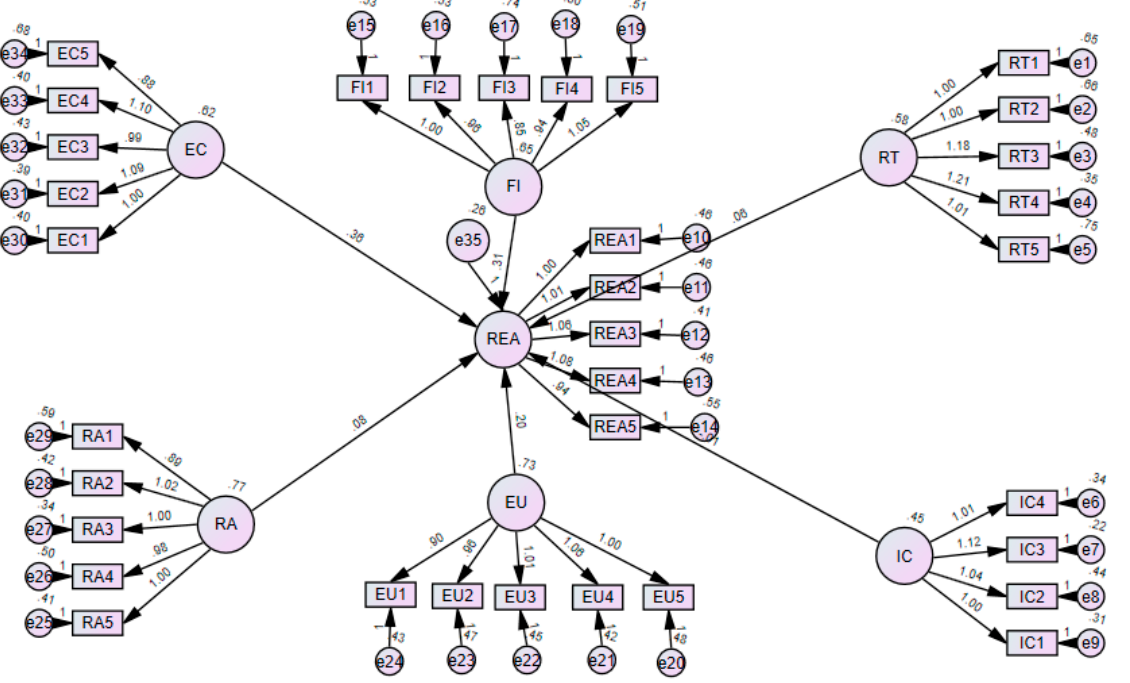
Figure 3. Evaluation of structural equation modeling results.